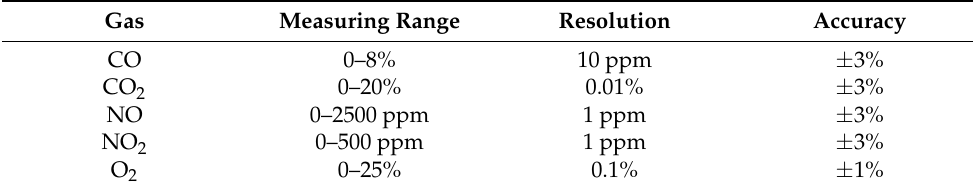
Table 2. Measuring range, resolution, and accuracy of